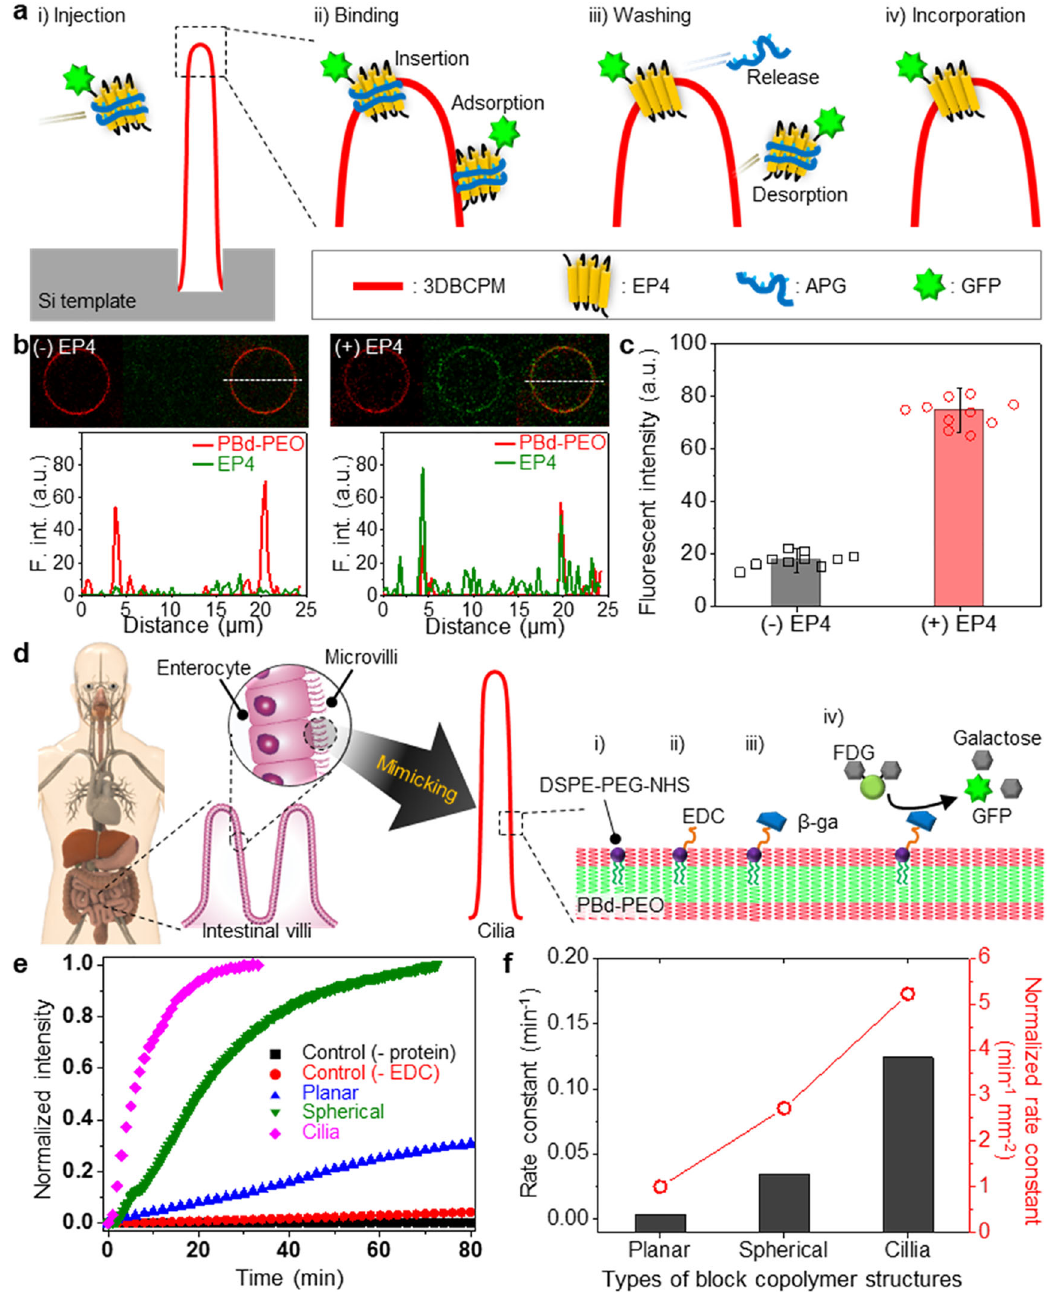
Fig. 5 Two representative biological applications based on a 3DBCPM as a platform. a Study of protein – membrane interaction by incorporating EP4 proteins that were conjugated with a green fl uorescent protein (GFP) and stabilized with amphipathic poly- γ -glutamic acid (APG): (i) injection of EP4; (ii) Insertion and adsorption of EP4 to 3DBCPM; (iii) Release of APG from 3DBCPM and desorption of adsorbed EP4 by repeated washing; and (iv) Successful incorporation of EP4 to 3DBCPM. b Cross-sectional confocal fl uorescence microscopy images (top) and fl uorescence intensities (bottom) of 3DBCPMs without (left) and with (right) EP4 incorporation. c Con fi rmation of the protein reconstitution on the 3DBCPM by distinguishing groups of fl uorescence intensities of the 3DBCPM membranes incorporated without and with EP4. Data are presented as means±standard deviation ( n = 10 independent samples). d Fabrication and working principles of 3DBCPM-based arti fi cial intestinal organs: (i) introduction of 1mol% of 1,2-distearoyl-sn-glycero-3-phosphoethanolamine- N -[succinimidyl(polyethylene glycol)] (DSPE-PEG-NHS) onto the 3DBCPM; (ii) coupling of NHS with 1-ethyl-3-(3-dimethylaminopropyl)carbodiimide (EDC); (iii) conjugation of beta-galactosidase ( β - Ga); and (iv) enzymatic reaction where fl uorescein di- β - D -galactopyranoside (FDG) is hydrolyzed into galactose by β -Ga, releasing GFP molecules that cause an increase in fl uorescence. e Comparison of time-dependent enzymatic kinetics of the proposed spherical and cilia-like 3DBCPMs and a planar block copolymer structure by monitoring the normalized fl uorescence intensities after the enzymatic reaction. f Estimated enzymatic reaction rate constants and surface-area- normalized rate constants of three different block copolymer structures: planar, spherical, and cilia.